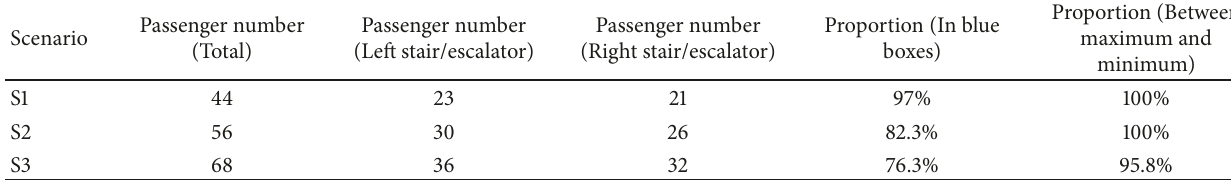
Table 3: Scenario setting and experiment results.